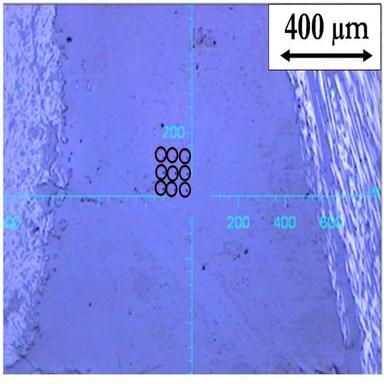
Microscopic image of a resin pocket located in the YZ plane, perpendicular to the weft direction.